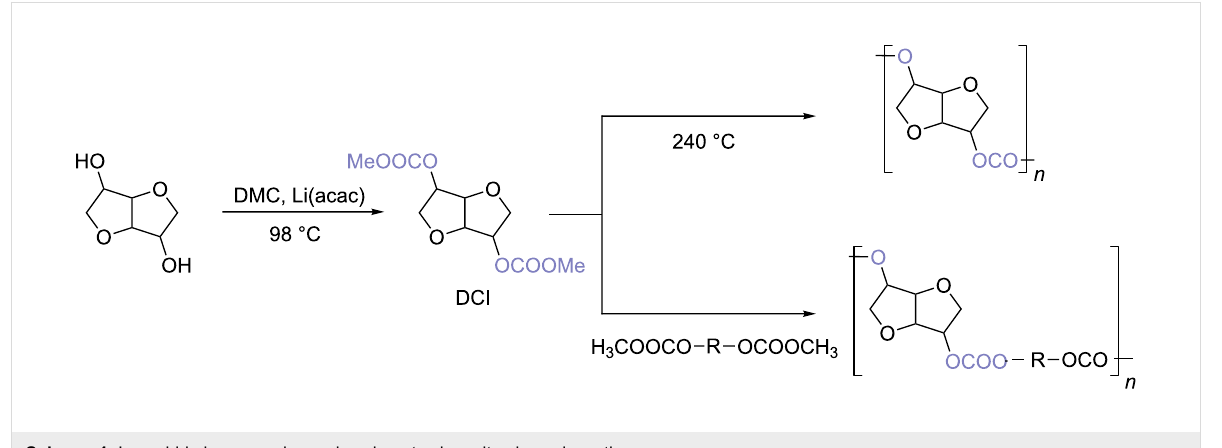
Scheme 4: Isosorbide homo- and co-polycarbonate via melt polycondensation.